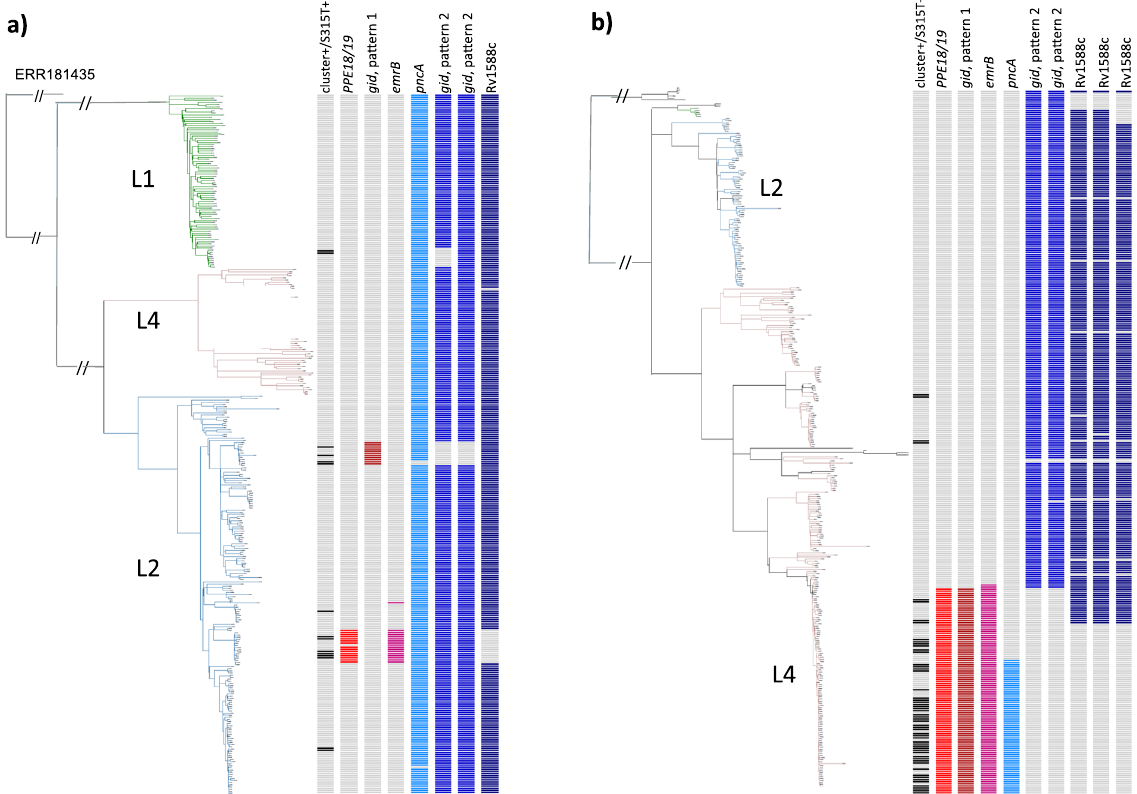
Figure 3. Distribution of k-mers derived from variant (or wild) types of five genes ( PPE18/19, gid, emrB, Rv1588c , and pncA ) that showed positive or negative associations with clustered strains carrying katG -S315T in the phylogenetic trees of Hanoi ( a ) and KwaZulu-Natal ( b ) study